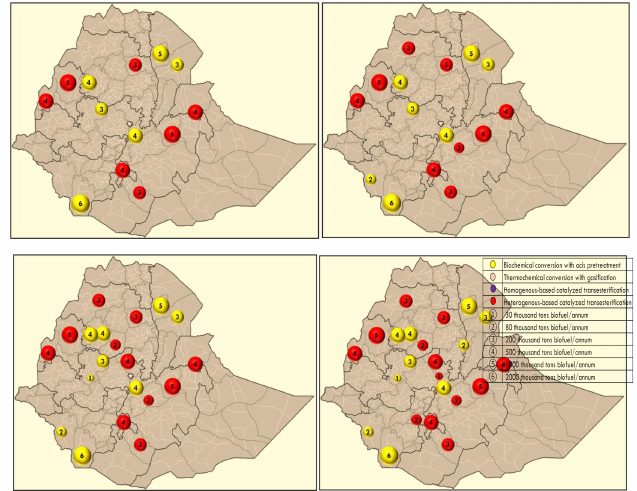
Figure 5. Strategic decisions proposed by Scenario F on locations, technologies and capacities of refineries for the years 2020/2021–2024/2025 ( upper left ), 2025/2026–2029/2030 ( upper right ), 2030/2031–2034/2035 ( lower left ), and 2035/2036–2039/2040 ( lower right ).